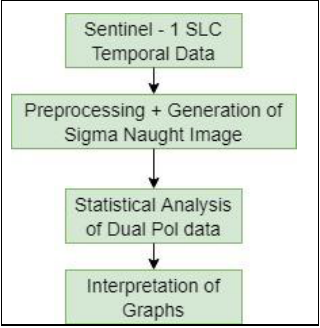
Figure 4: Methodology Flowchart of first